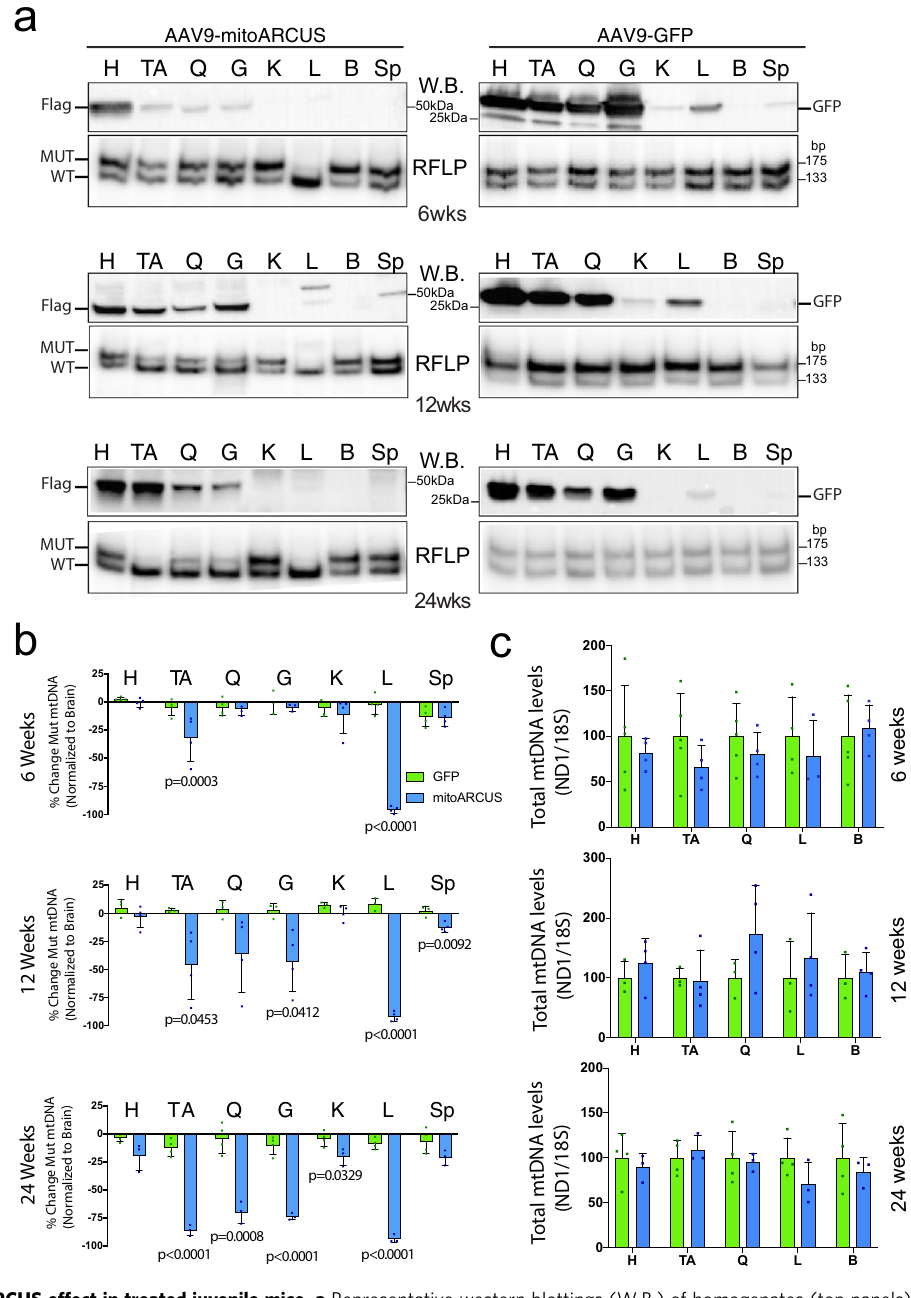
Fig. 3 AAV9-mitoARCUS effect in treated juvenile mice. a Representative western blottings (W.B.) of homogenates (top panels) with Flag antibody for AAV9-mitoARCUS samples and GFP antibody for AAV9-GFP samples. RFLP “ last-cycle hot ” PCR analysis (RFLP, bottom panels) of DNA samples from the same injected animals at 6, 12, and 24 weeks PI. Similar analyses were performed for each animal. b Quanti fi cation of heteroplasmy shift shown as a percent change in heteroplasmy across all tissues at 6, 12, and 24 weeks PI normalized to brain tissue. Heteroplasmy levels of the heart (H), tibialis anterior (TA), quadriceps (Q), gastrocnemius (G), kidney (K), liver (L), and spleen (Sp) were compared to that of the brain (B) (negative for expression of mitoARCUS). c Quanti fi cation by RT-PCR of total mtDNA levels in the skeletal muscle, liver, and brain at 6 and 24 weeks PI using ND1 and ND5 mitochondrial primer/probes normalized to 18S (nuclear DNA). Data are mean ± SEM of n = 4 (with exception of 6 weeks GFP ( n = 5) and 24 weeks mitoARCUS ( n = 3)). Statistical analysis was performed using two-tailed Student ’ s t -test. variation within the amplicon, such as an indel. No indels were that is less permissive to AAV-mediated expression compared to detected at any of the sites analyzed for any of the animals. 2.5 weeks. Still, a strong expression was observed in the heart and liver, with weaker expression in skeletal muscles (Fig. 4a). AAV9- GFP-injected mice showed strong expression in the heart, TA, MitoARCUS effectively shifted mtDNA heteroplasmy in adult and liver, with weaker expression in quadriceps and gastro- animals . Heteroplasmic m.5024C>T mice were also injected cnemius (Fig. 4a). RFLP analysis showed an essentially complete systemically with AAV9-mitoARCUS at 6 weeks of age, an age elimination of mutant mtDNA in the liver as early as 6 weeks NATURE COMMUNICATIONS| (2021) 12:3210